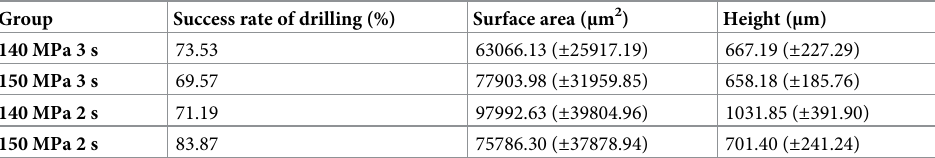
Table 1. Basic information about cavity drill with different pressure and time. Data represent the mean ( ± SD).